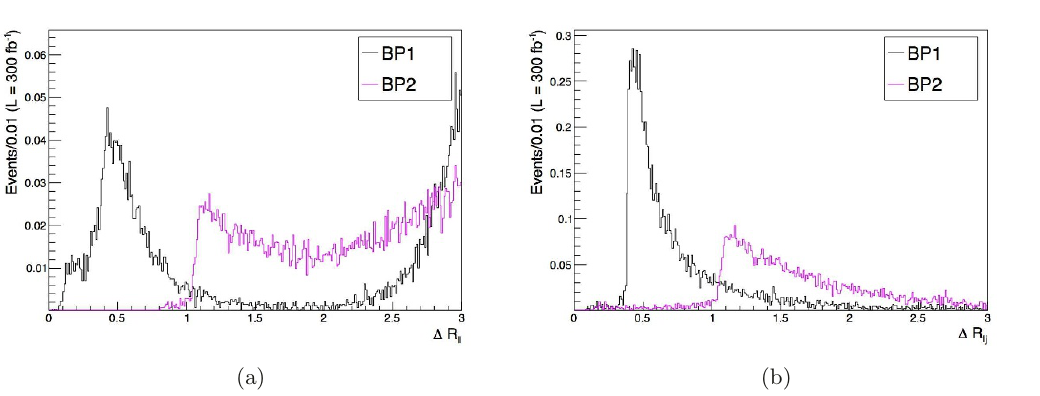
Figure 10 . (a) Distribution in the angular separation between the leptons averaged over the three possible pairs. Black and magenta lines refer to BP1 and BP2 scenarios, respectively. (b) Distribution in the angular separation between the fat jet and the closest lepton. The color code is the same as in (a). A luminosity = 300fb − 1 is L